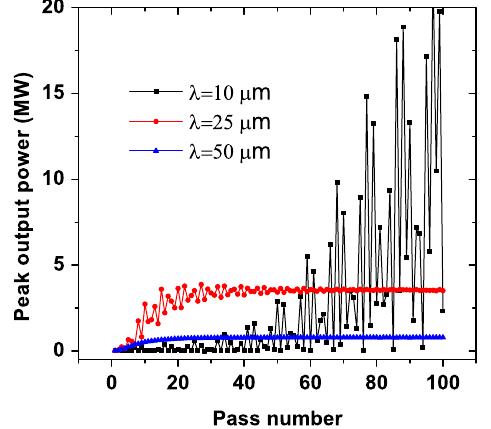
FIG. 6. Outcoupled power as a function of pass number, for three different wavelengths, with a hole size 1 mm, and g ¼ − 0 . 6 .